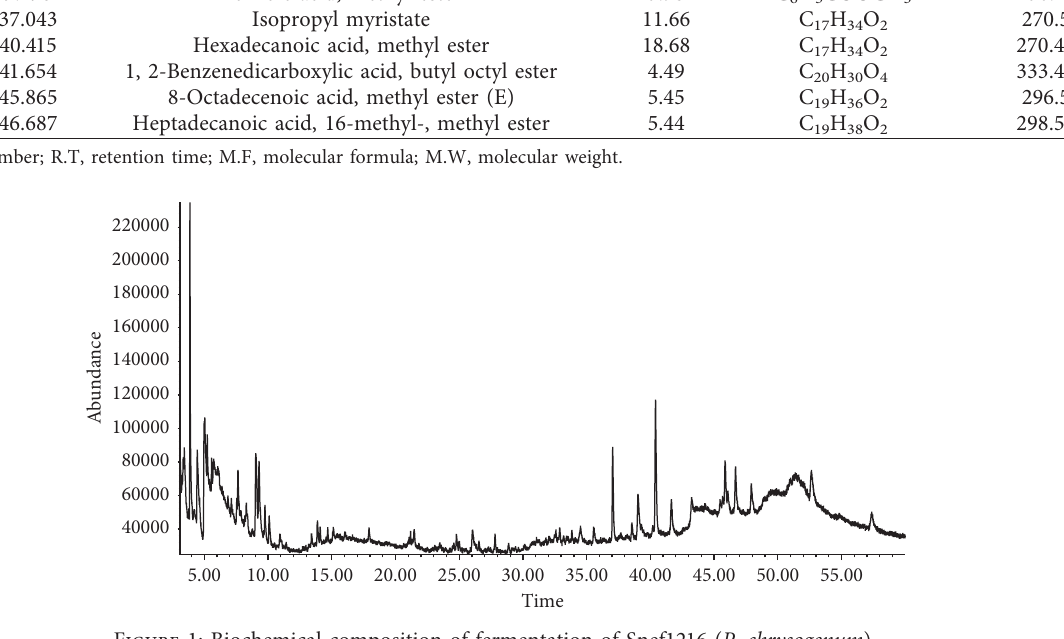
Figure 1: Biochemical composition of fermentation of Snef1216 ( P. chrysogenum